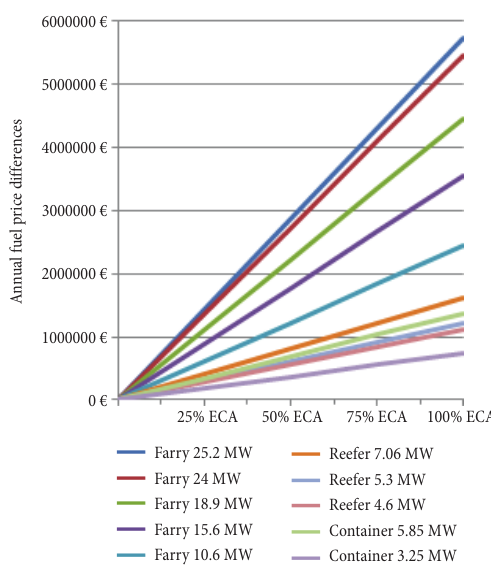
Fig. 3. Annual fuel price differences between using of IFO and LSMGO concerning transit time in ECA